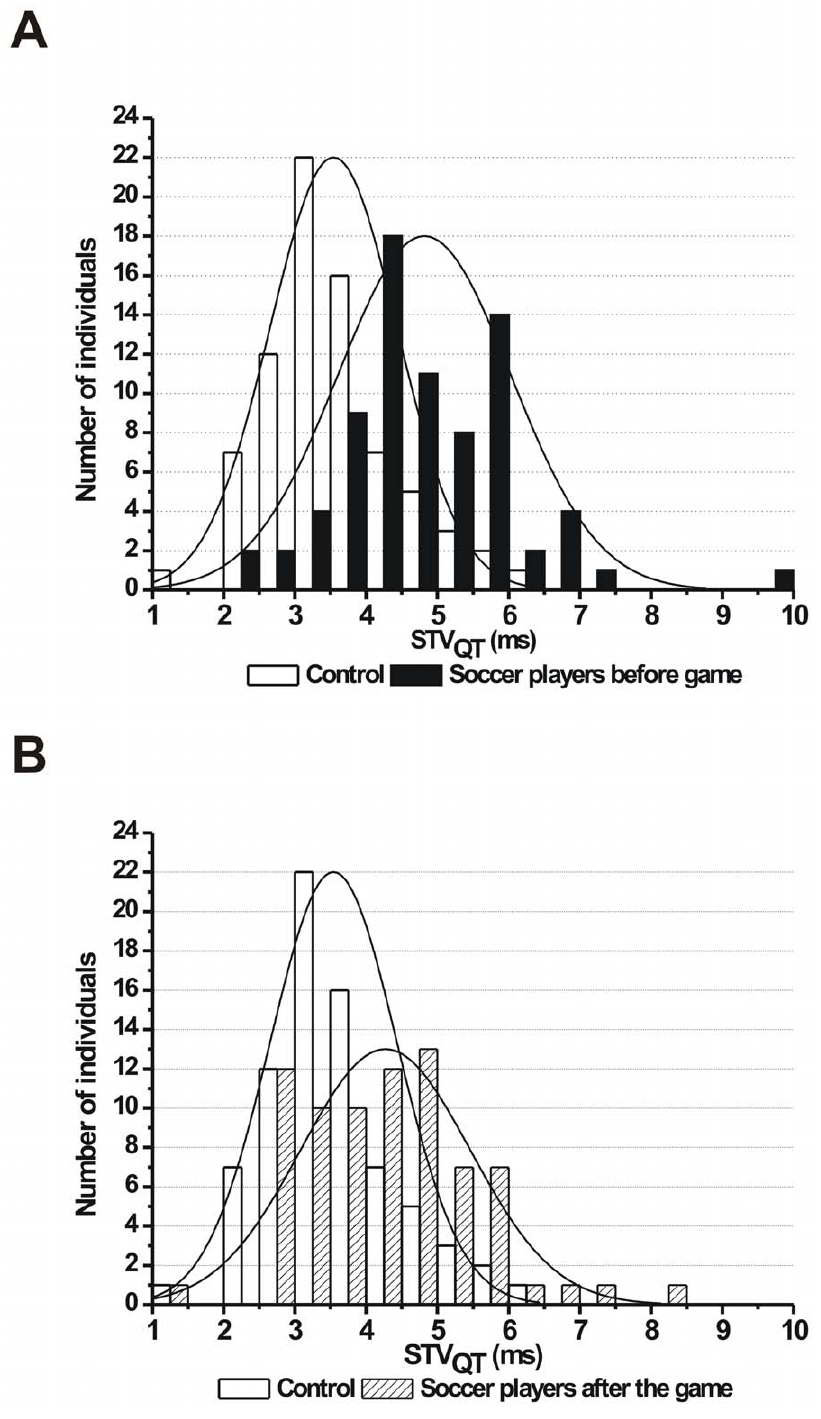
Figure 6. Histograms showing the distribution of short-term beat-to-beat variability of the QT interval (STV QT ). ( A ) Controls (empty bars) and soccer players before game (full bars) and ( B ) controls (empty bars) and soccer players after the game (hashed bars). Bin size is 0.5 ms. (n=76 persons/group).